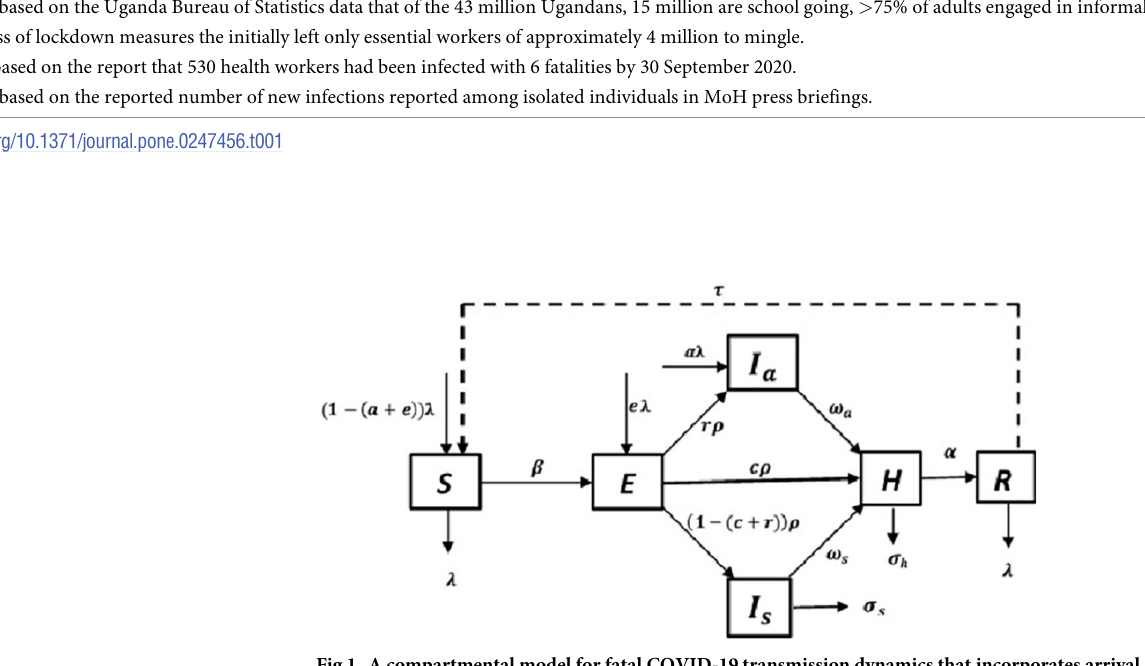
Fig 1. A compartmental model for fatal COVID-19 transmission dynamics that incorporates arrival of infected and susceptible individuals and departure of susceptible and/or recovered individuals and incorporates contact tracing and isolation of suspected contacts of infectious individuals. The boxes represent population sub-groups while the arrows indicate the flow of individuals. The dashed arrow presents a yet-to-be resolved aspect on nature, if any, of immunity conferred by the disease upon